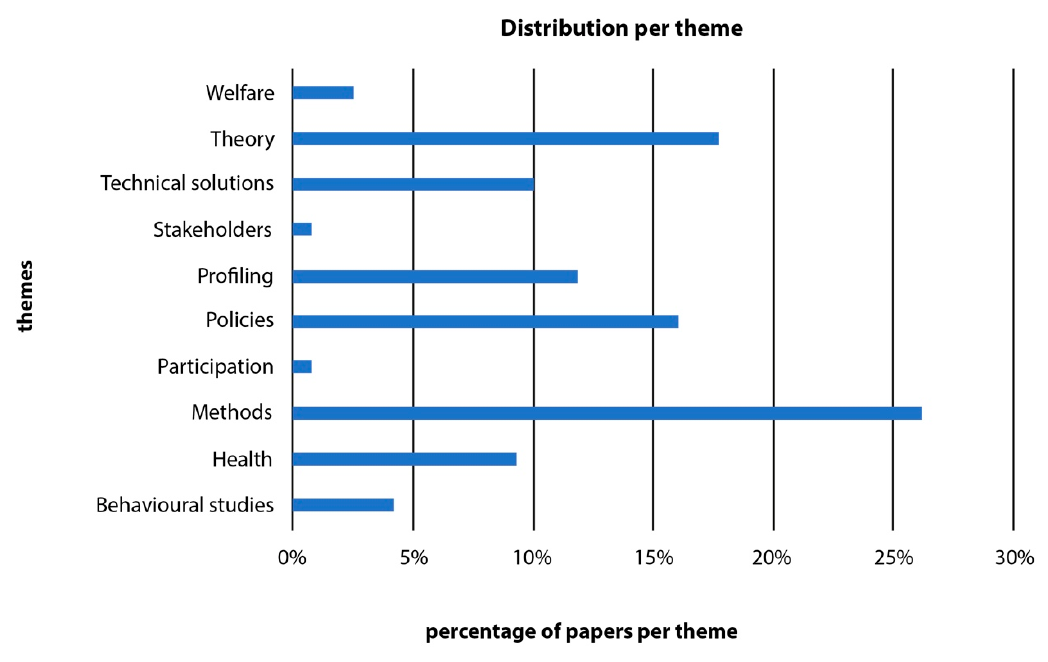
Figure 4. The graphic in the image represents the thematic distribution of the papers analyzed.